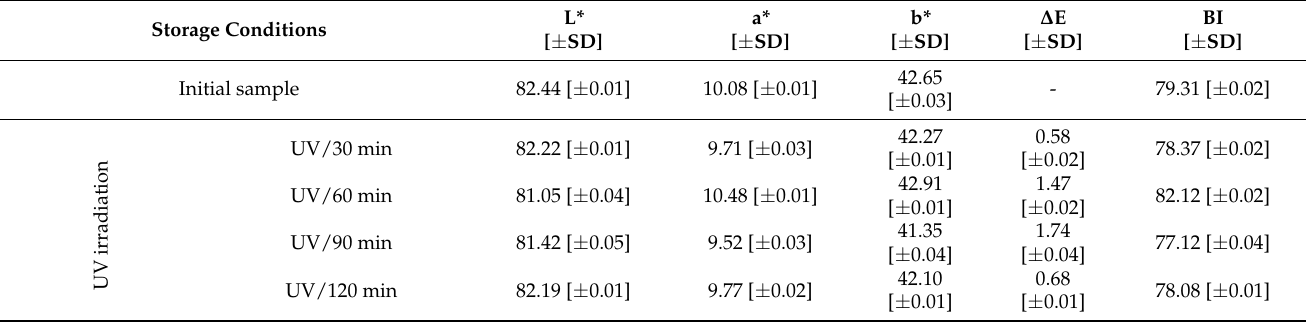
Table 1. Analysis of color in the CIE L*a*b* space, total color difference ( ∆ E), and browning index (BI) parameters for gum arabic storage in different